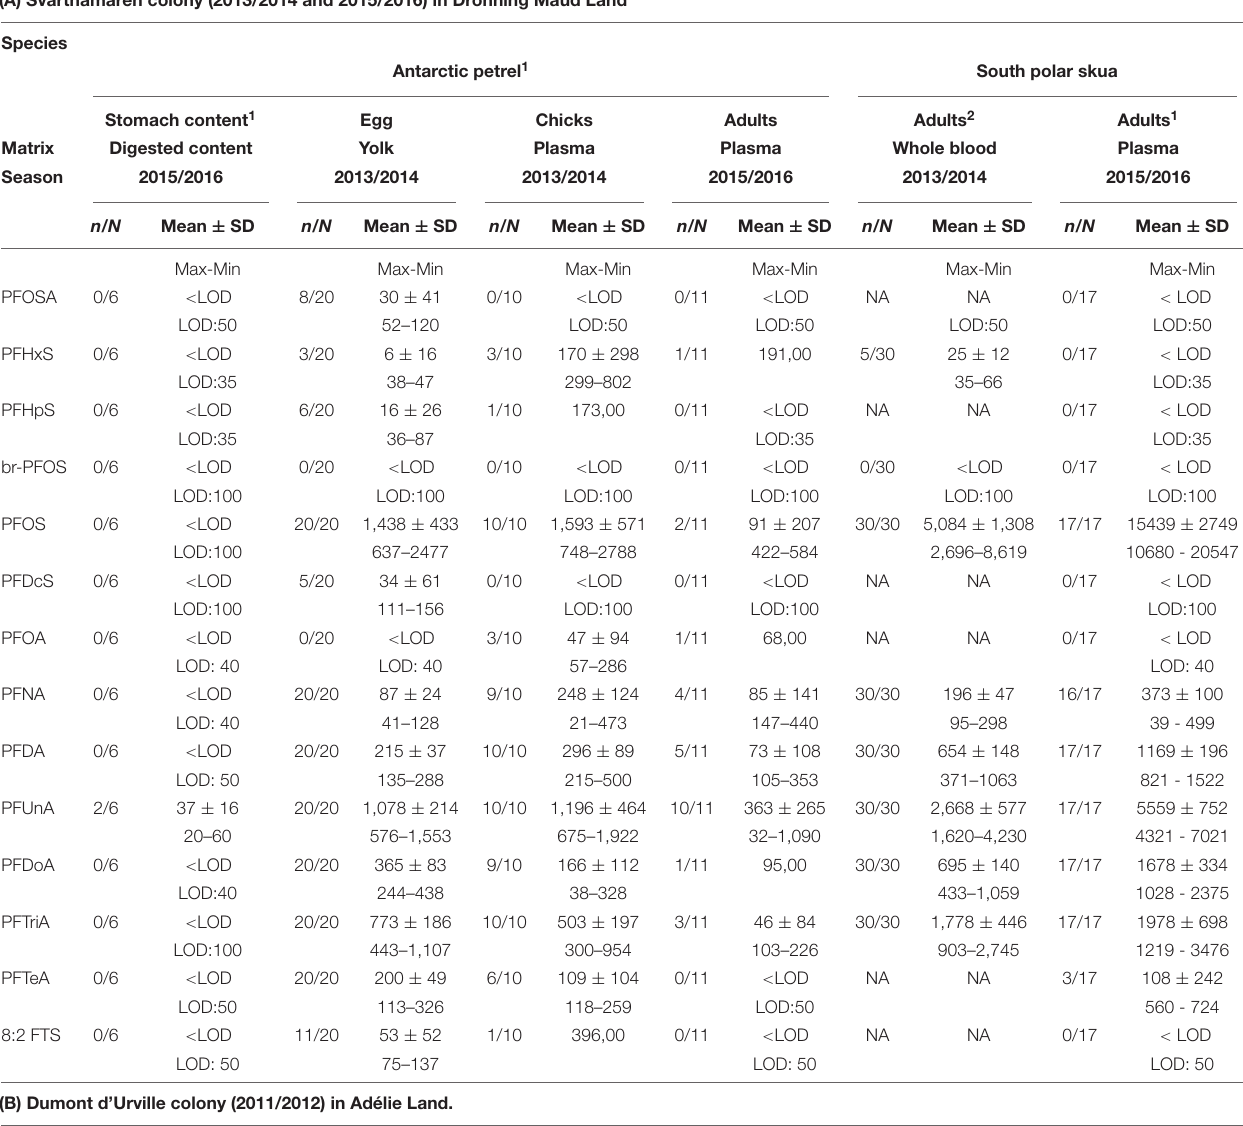
TABLE 1 | Per- and polyfluoroalkyl substance (PFAS) concentrations (pg/g wet weight) in south polar skuas and food web items. (A) Svarthamaren colony (2013/2014 and 2015/2016) in Dronning Maud Land